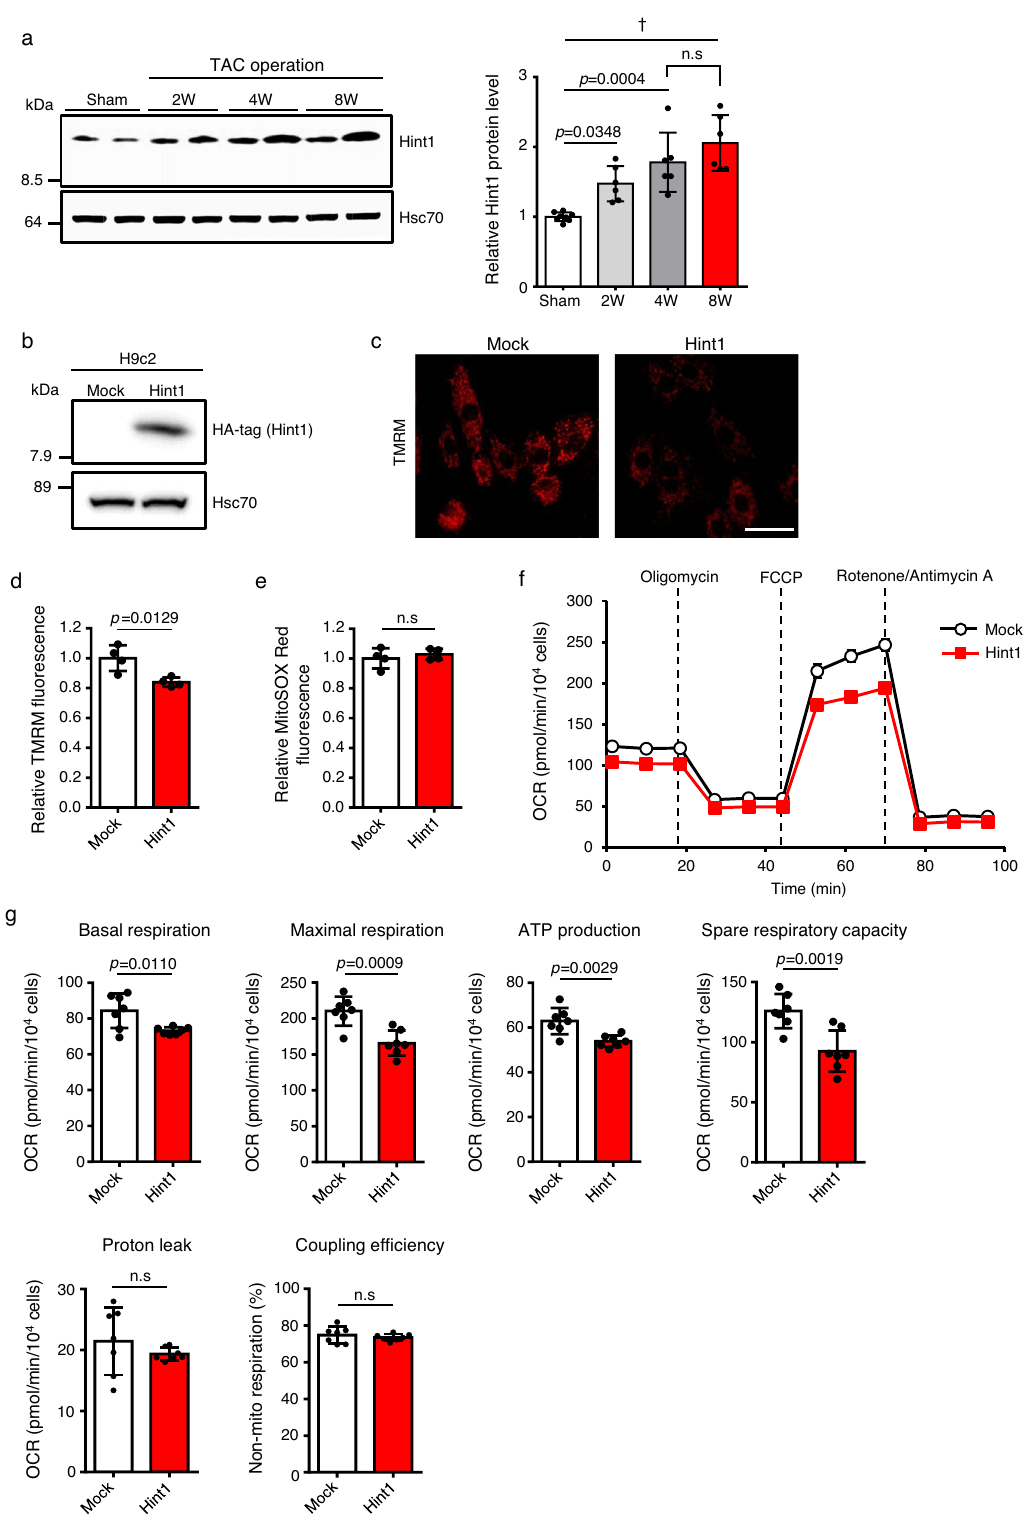
(5 ’ -CATTCCTTCCGCTAGCTTTTATTG-3 ’ ) and reverse (5 ’ -AAGTCCCATAAG GTCATGTACTGG-3 ’ ) primers. To maintain an isogenic strain, mice were pro- pagated as heterozygotes by breeding with WT C57BL/6 N mice. Generation of α MHC - Caren transgenic mice . Mouse Caren cDNA was cloned into the murine α MHC promoter expression vector 32,60 (Supplementary Fig. 5a). To identify Tg offspring, genomic PCR was performed with forward (5 ’ -CAG- GACTTCACATAGAAGCC-3 ’ ) and reverse (5 ’ -CCAGGCAGTCATGATGCAGG-